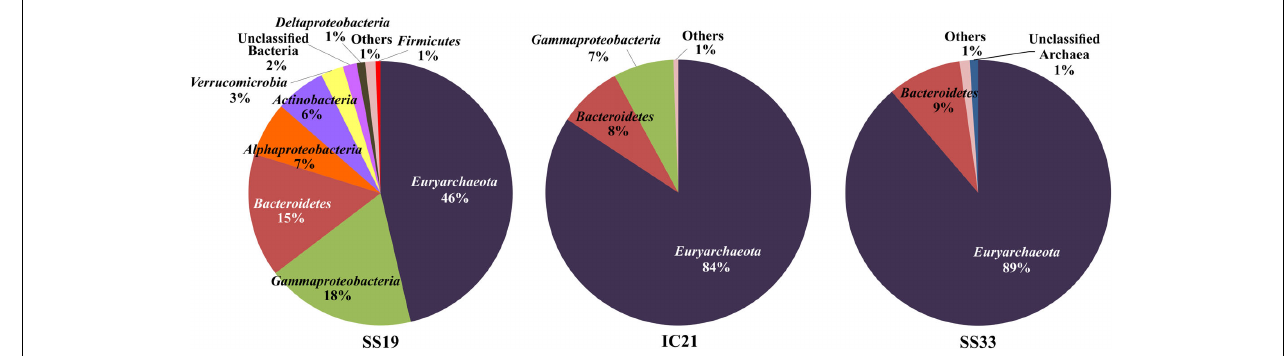
FIGURE 4 | Representation of high taxonomic levels affiliated to metagenomic rRNA reads. Assigned sequences have an identity over 80% and a minimum length of 100bp.